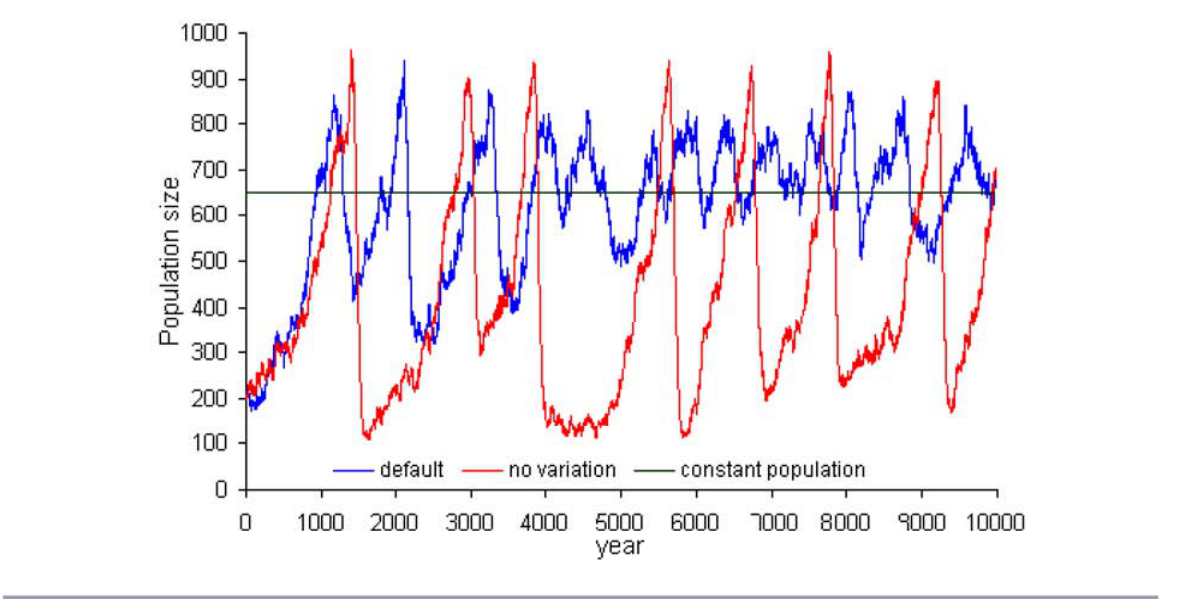
Fig. 7. Population size for typical simulations with constant population size, and no climate variability, next to the default